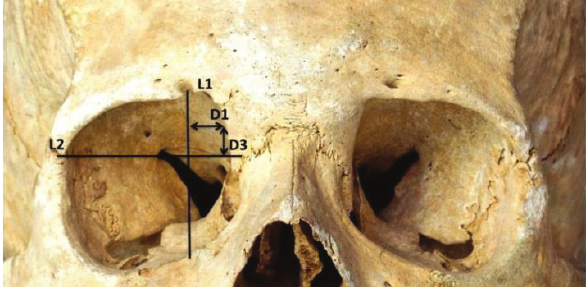
Fig-1: (L1) and (L2) are shown passing through the supraorbital notch and fronto zygomatic suture respectively. (D1) indicates the interspace between trochlear fovea/spine and (L1) while (D3) indicates the interspace from (L2).